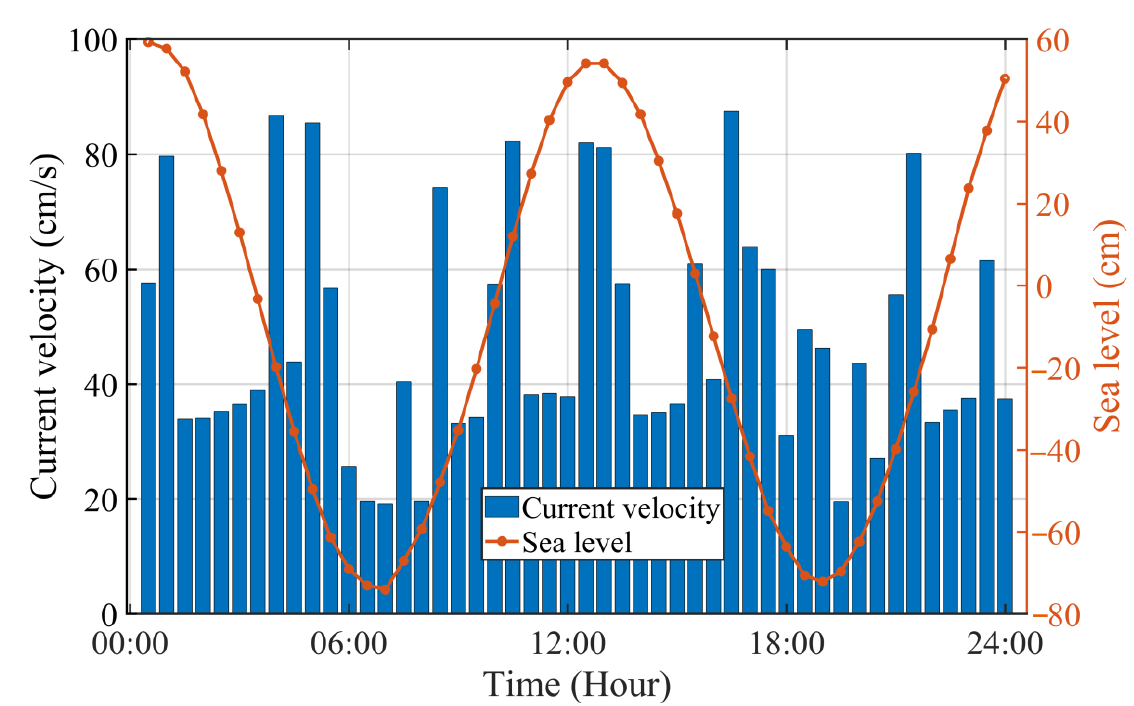
Figure 12. Current velocity (bars) and sea level (red line) from 17 October 2019 to 20 February 2010.